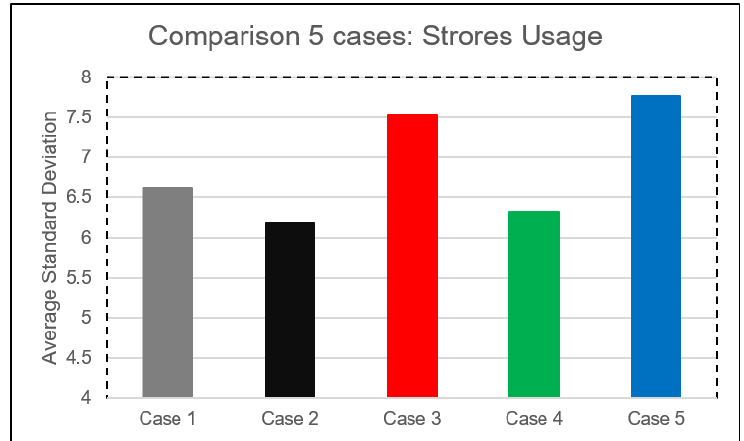
Figure 11. Simulation Results: Average Standard Deviation based on 100 runs for Stores’ Usage.